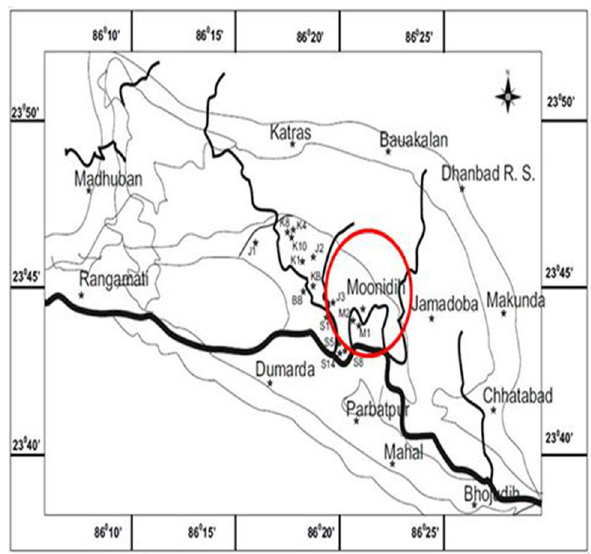
Fig. 1 Geological setting of Jharia coalfield (Moonidih